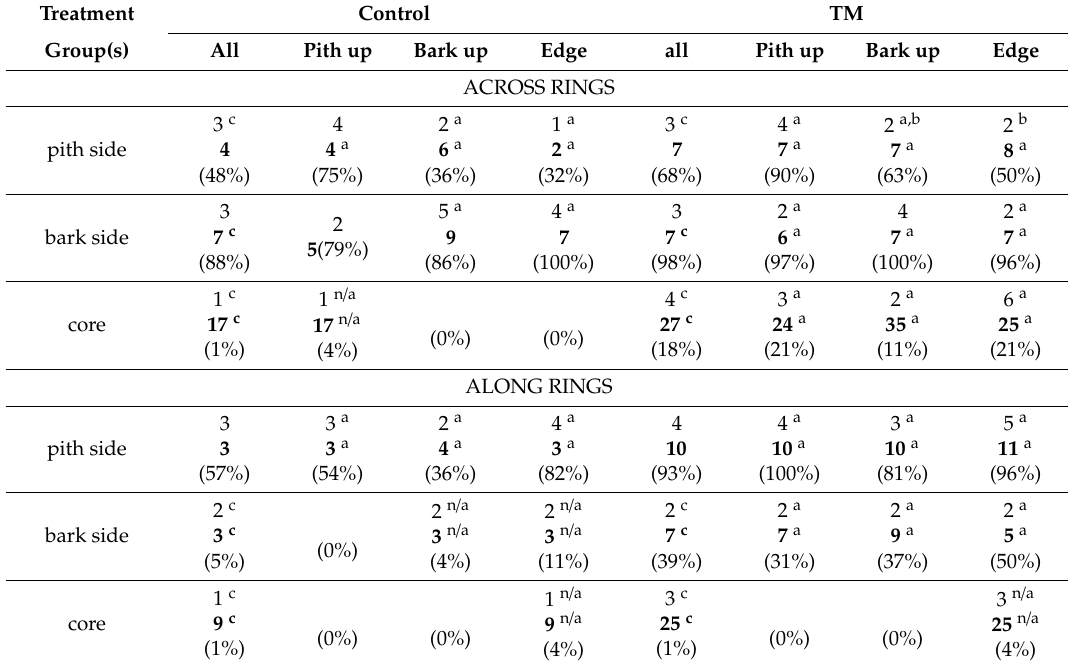
Table 3. Checks in cross-section of ‘exposed’ control and TM boards for all boards and per group: mean values of number of observations [no.] and maximum depth [mm] (in bold), and percentage occurrence [%] in parenthesis.